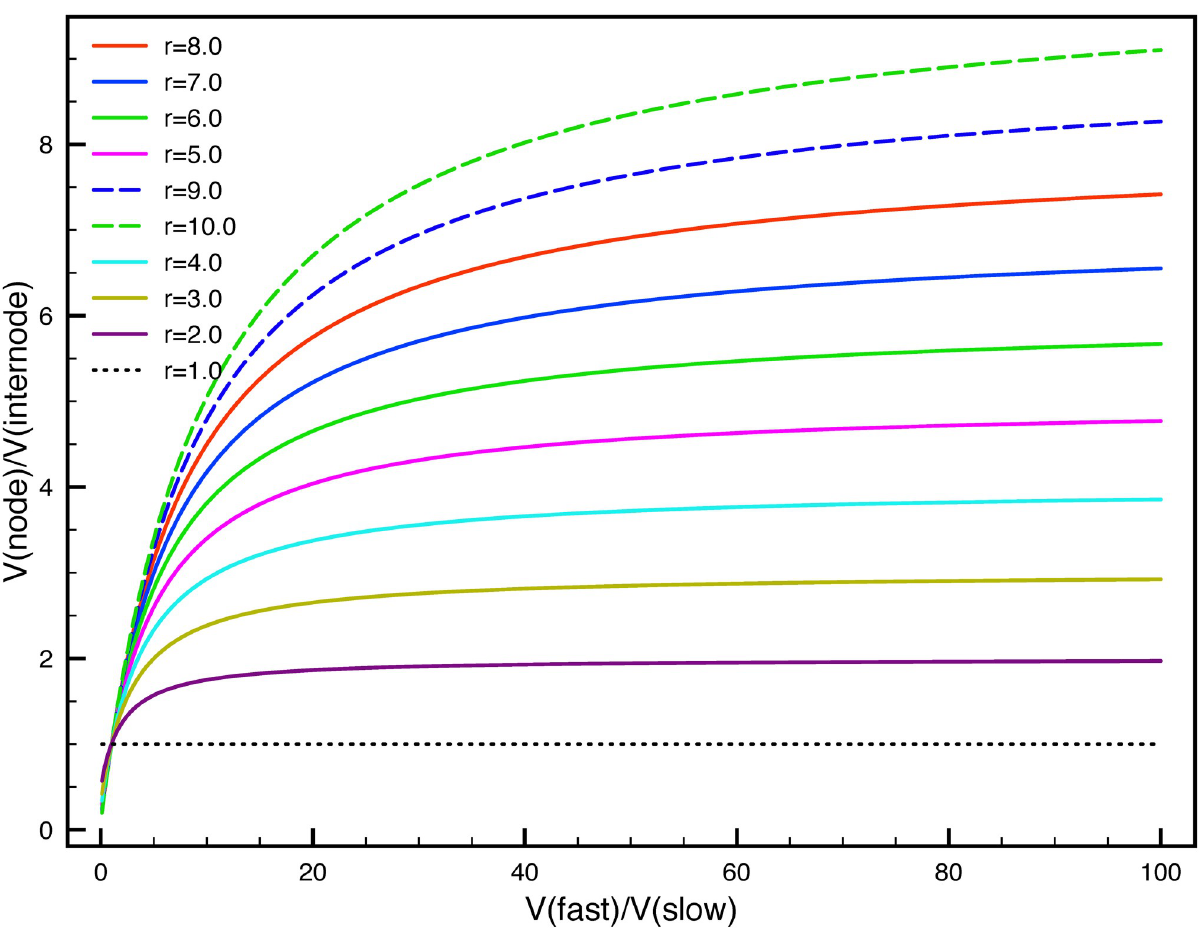
Fig 2. The dependence of velocity boost on the rate ratio between phosphorylation and dephosphorylation r = γ ph : γ ratio n between the node V(fast) and internode V(slow) without the phosphorylation kinetics. The y-axis is the velocity ratio between node V(node) and internode V(internode) with the phosphorylation kinetics.